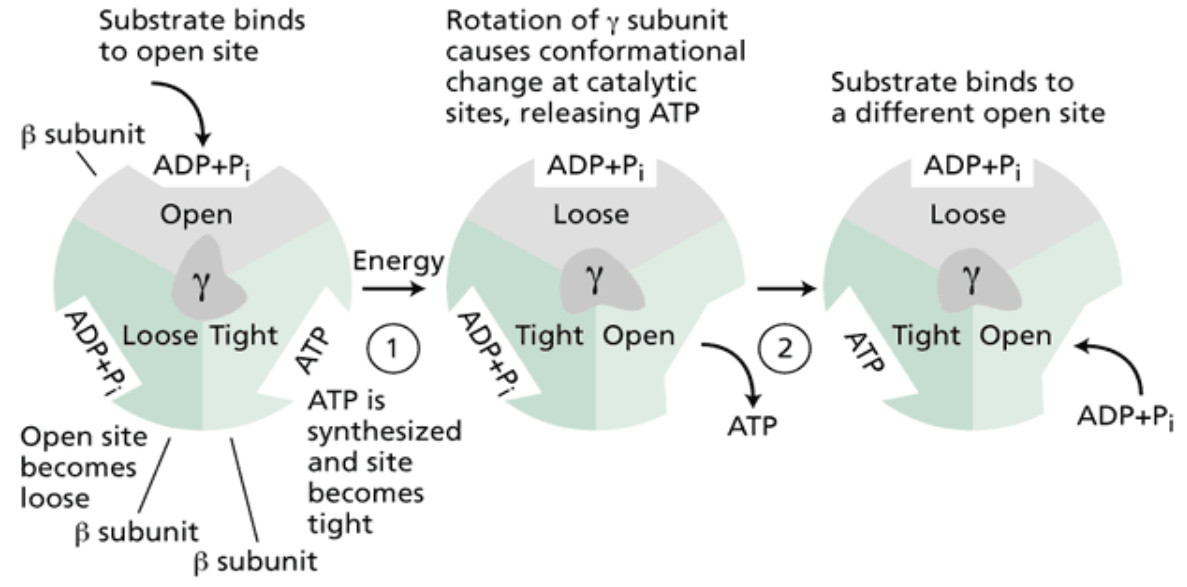
complex.There are three catalytic sites in three different 1 ) initially binds to the open site i